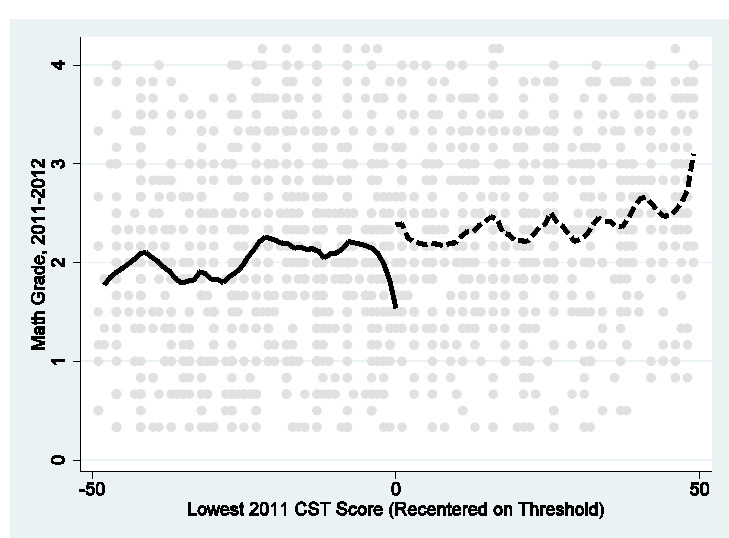
Figure S7: Regression discontinuity analysis of the effect of white card placement on Spring 2012 math grades, for 2011-12 Live Oak and Mann students (preferred bandwidth: